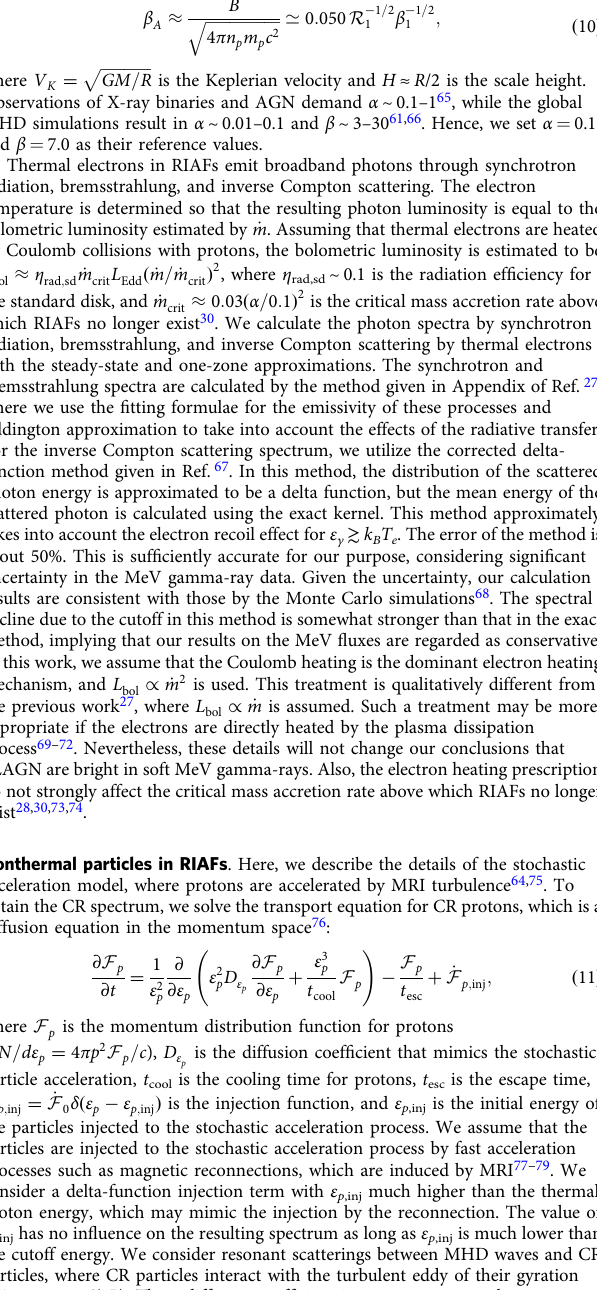
ffiffiffiffiffiffiffiffiffiffiffiffiffiffiffiffiffiffiffiffi 8 π n p k B T p